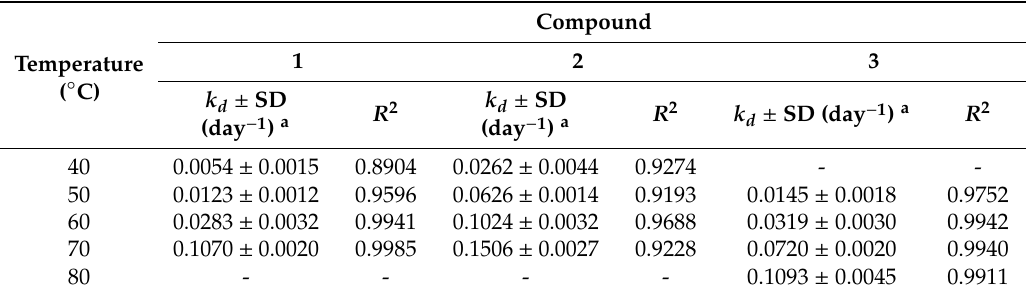
Table 2. Degradation rate constants for compounds 1 – 3 in AE solution, estimated by the mean of a first-order kinetic model.